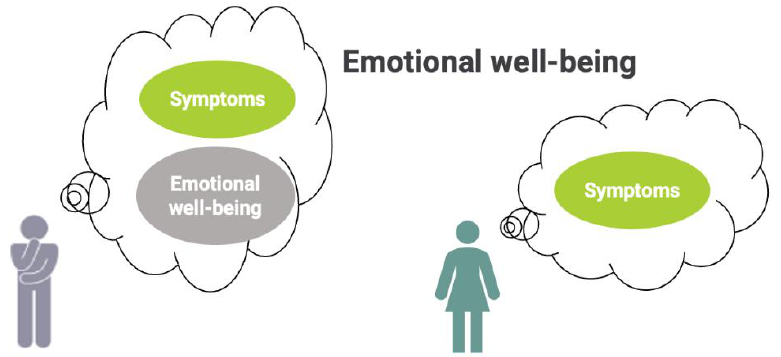
Figure 3. Bill (in grey) includes different factors in his definition of health compared to others (lack of configural invariance).